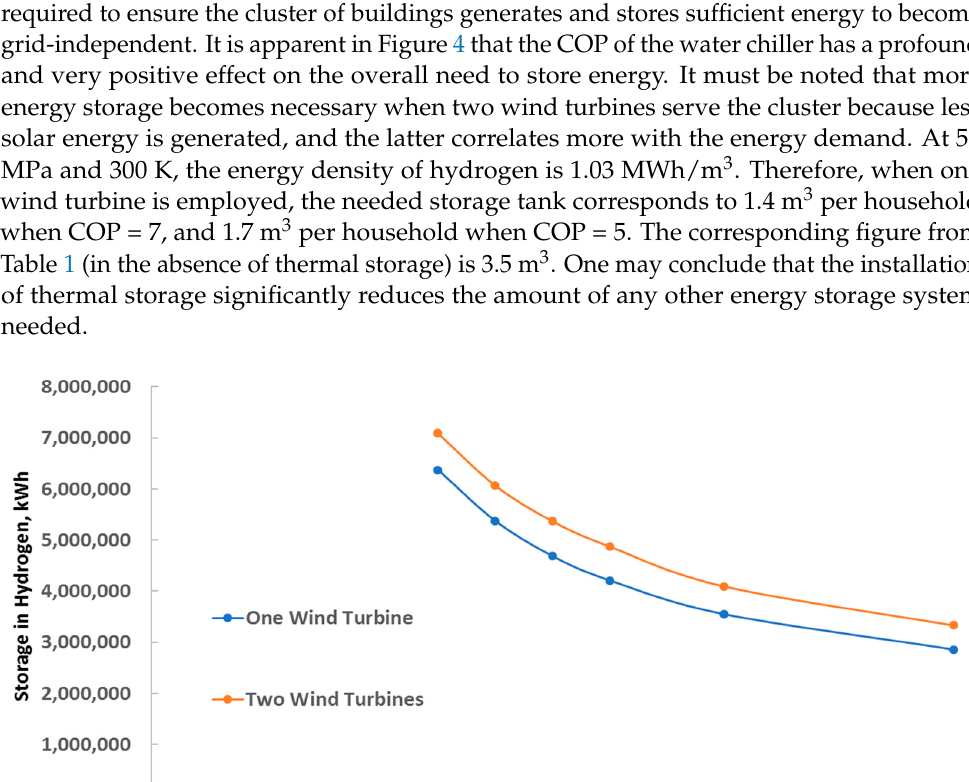
Figure 3. ( a ) Photovoltaics area needed, annual energy demand, supply, and dissipation as a function of the COP when one wind turbine is employed. ( b ) Photovoltaics area needed, annual energy demand, supply, and dissipation as a func- tion of the COP when two wind turbines are employed.